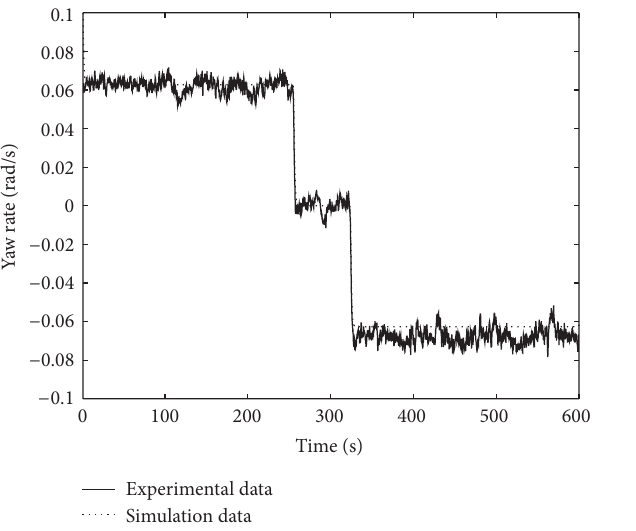
Figure 8: Error in the identification of the yaw rate, that is, difference between the yaw rate obtained in simulation and in the real